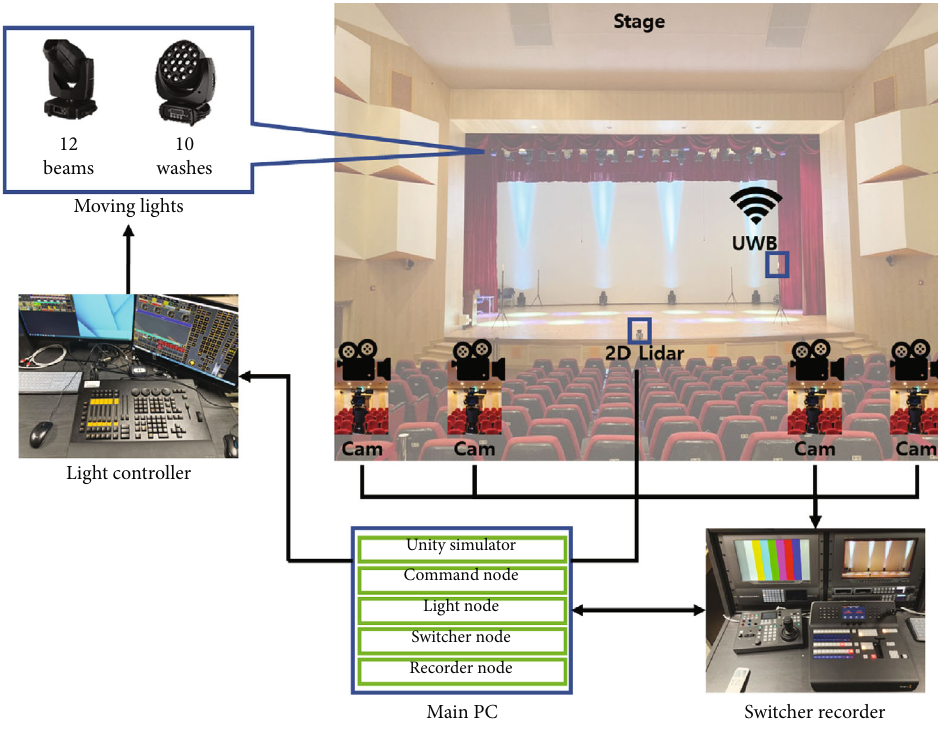
Figure 2: Overall system con fi guration and connection diagram.